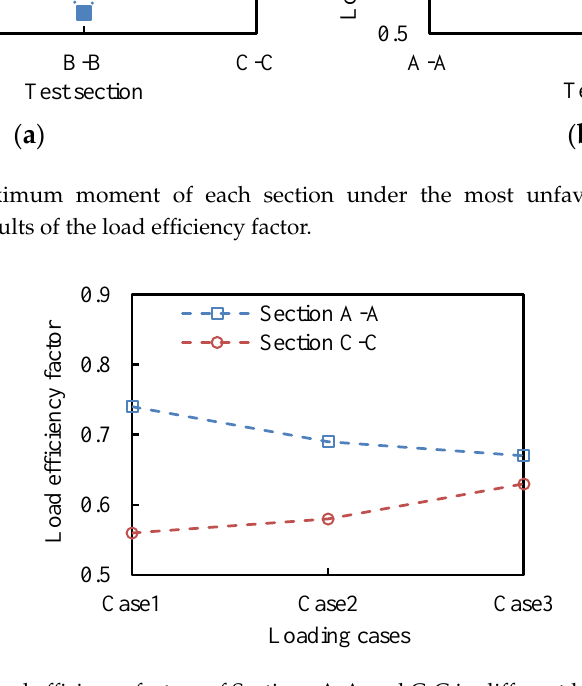
Figure 6. Load efficiency factors of Sections A-A and C-C in different loading cases.